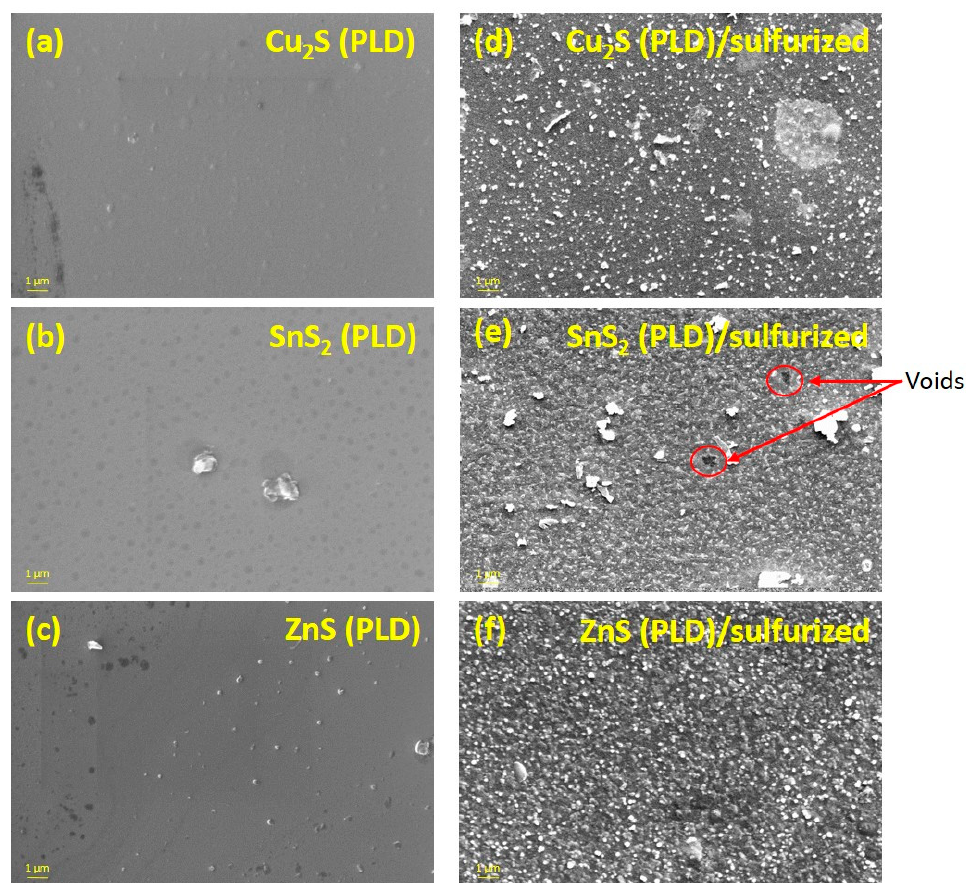
Figure 4. Surface SEM images of the samples on glass substrate as-deposited and sulfurized: ( a ) Cu 2 S (PLD), ( b ) SnS 2 (PLD), and ( c ) ZnS (PLD) (as-deposited); ( d ) Cu 2 S (PLD)/sulfurized, ( e ) SnS 2 (PLD)/sulfurized, and ( f ) ZnS (PLD)/sulfurized (sulfurized).